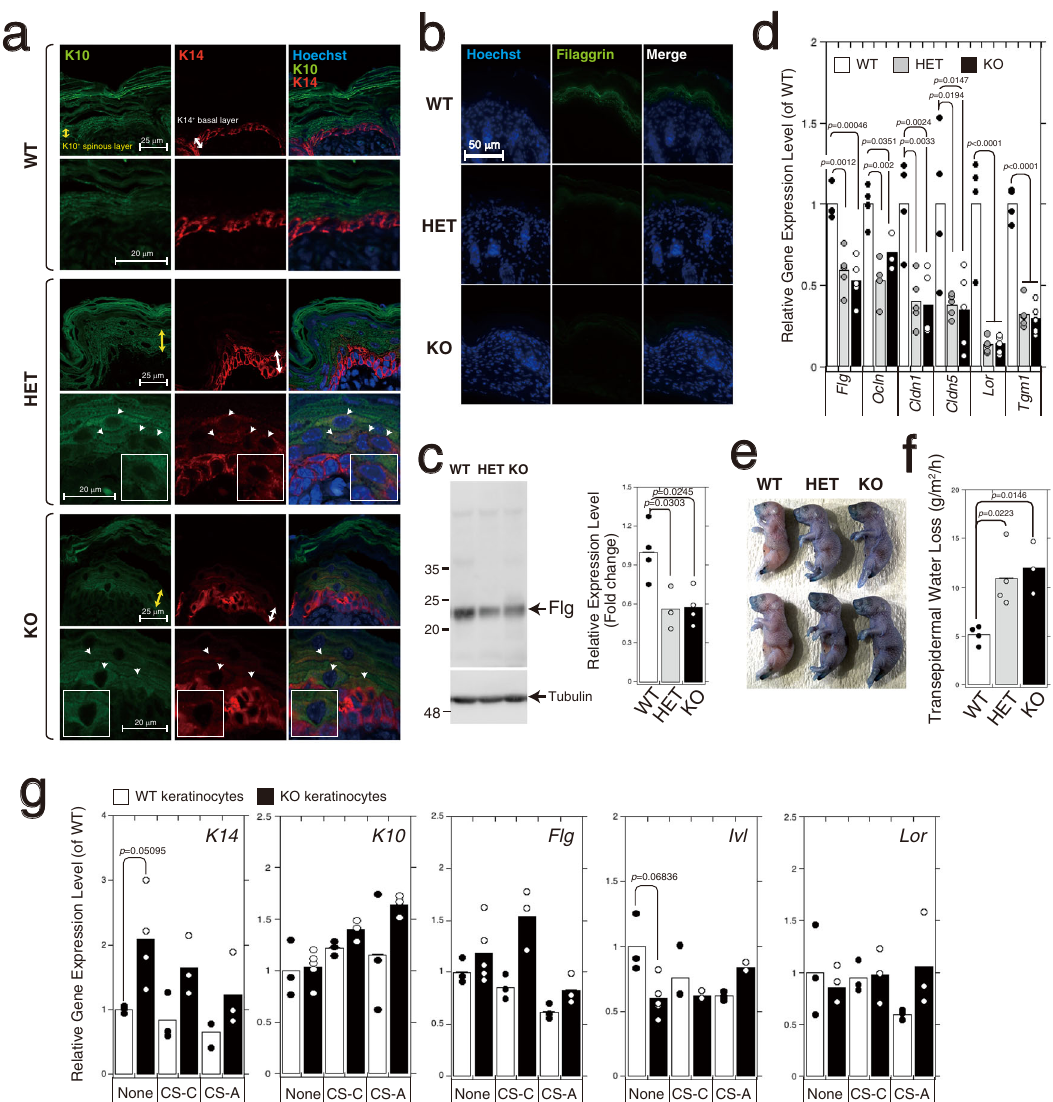
Fig. 3 Expression of skin proliferation/differentiation markers and skin barrier function is disrupted in C6st-1 HE and C6st-1 KO mice. a Immuno fl uorescence analysis of skin sections from C6st-1 WT, C6st-1 HE, and C6st-1 KO mice is presented. Green signals indicate K10 and red signals show K14. Positive labeling for K10 and K14 in the spinous layer (yellow arrows) and basal layer (white arrows), respectively, is shown. Magni fi ed images are shown below. Arrowheads indicate K10- and K14-double positive cells, and one of them is shown in the inset. b Immuno fl uorescence labeling of sections from the back skin of C6st-1 WT, C6st-1 HE, and C6st-1 KO mice was conducted using an anti- fi laggrin antibody (green). Nuclei were counterstained with Hoechst (blue). c Protein extracts from epidermis of C6st-1 WT ( n = 4), C6st-1 HE ( n = 3), and C6st-1 KO ( n = 4) were immunoblotted with anti- fi laggrin and anti-tubulin antibodies. Tubulin was used as loading control. Statistical signi fi cance was determined using one-way ANOVA with Tukey ’ s HSD test. d The expression levels of fi laggrin ( Flg ), occludin ( Ocln ), claudin 1 ( Cldn1 ), claudin 5 ( Cldn5 ), loricrin ( Lor ), and transglutaminase 1 ( Tgm1 ) in samples of C6st-1 WT ( n = 4), C6st-1 HE ( n = 4-5), and C6st-1 KO epidermis ( n = 3-5) were analyzed using real-time PCR . Statistical signi fi cance was determined using one- way ANOVA with Tukey ’ s HSD test. e Euthanized neonatal pups were immersed in toluidine blue solution. f TEWL was determined in 8-week-old C6st-1 WT ( n = 4), C6st-1 HE ( n = 4), and C6st-1 KO mice ( n = 3). Statistical signi fi cance was determined using one-way ANOVA with Tukey ’ s HSD test. g Expression levels of differentiation markers ( K14, K10, Flg, Ivl , and Lor ) in C6st-1 WT and C6st-1 KO keratinocytes in the presence or absence of CS-C or CS- A were analyzed using real-time PCR ( n = 3 – 5). Values represent the mean ± standard deviation. Statistical signi fi cance was determined using Student ’ s t